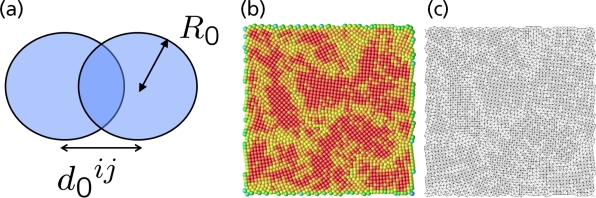
The particle Model as suggested in [195]. (a) Overlapping particles with radii R0 and the initial (randomly generated) degree of overlap indicated by d0ij. Here, only two particles are displayed. In the model the number of overlapping particles is unlimited and each individual particle pair contributes to the overall pressure and tensile strength of the solid. (b) Sample initial configuration of overlapping particles (N = 2500) with the color code displaying the coordination number: red (8), yellow (6), and green (4). (c) The same system displayed as an unordered network.